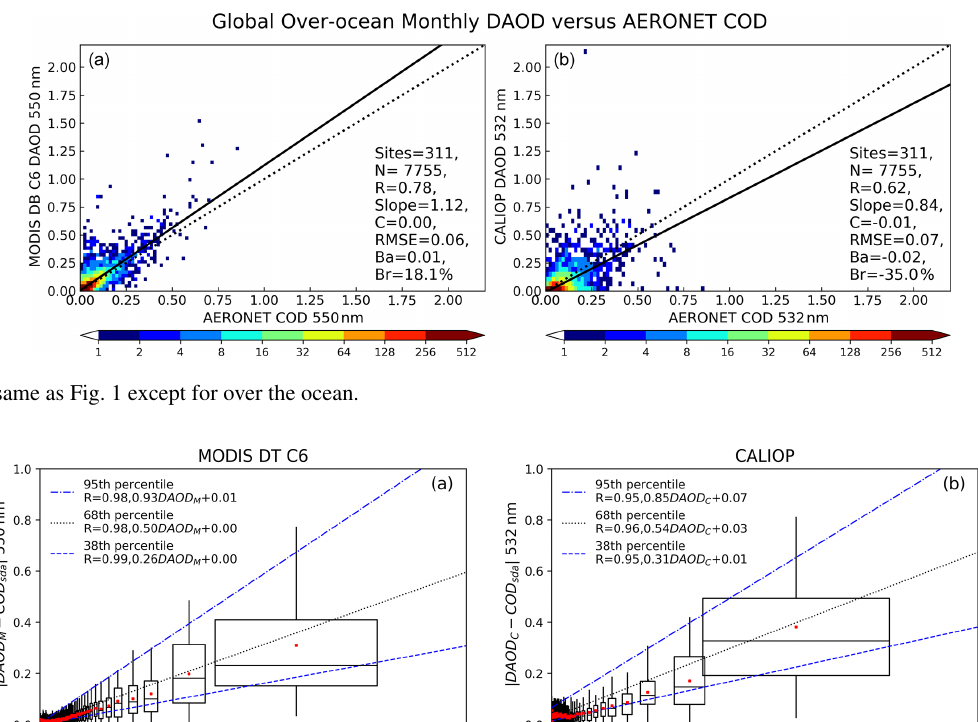
Figure 4. The same as Fig. 2 except for over the ocean.